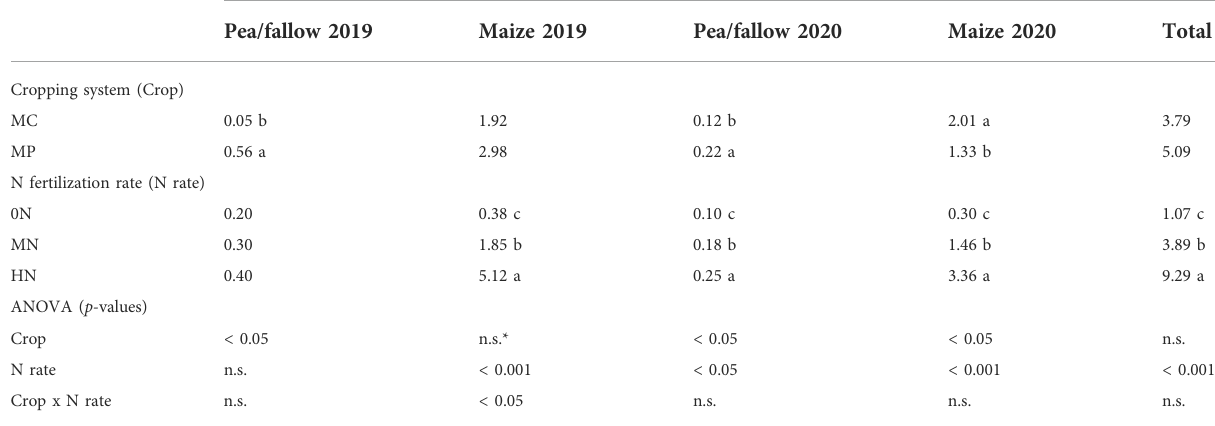
TABLE 3 Analysis of variance of cumulative soil N 2 O emissions for pea or fallow phases (Pea/fallow) and maize season (Maize) during 2019 and 2020 and the entire study duration (Total) as affected by cropping system (maize monoculture, MC; pea-maize rotation, MP), N fertilization rate (control, 0N; medium rate, MN, and high rate, HN) and their interaction.